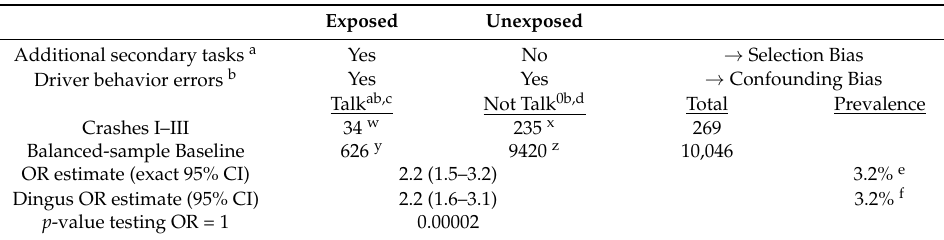
Table 1. Replication of Dingus study Talk OR